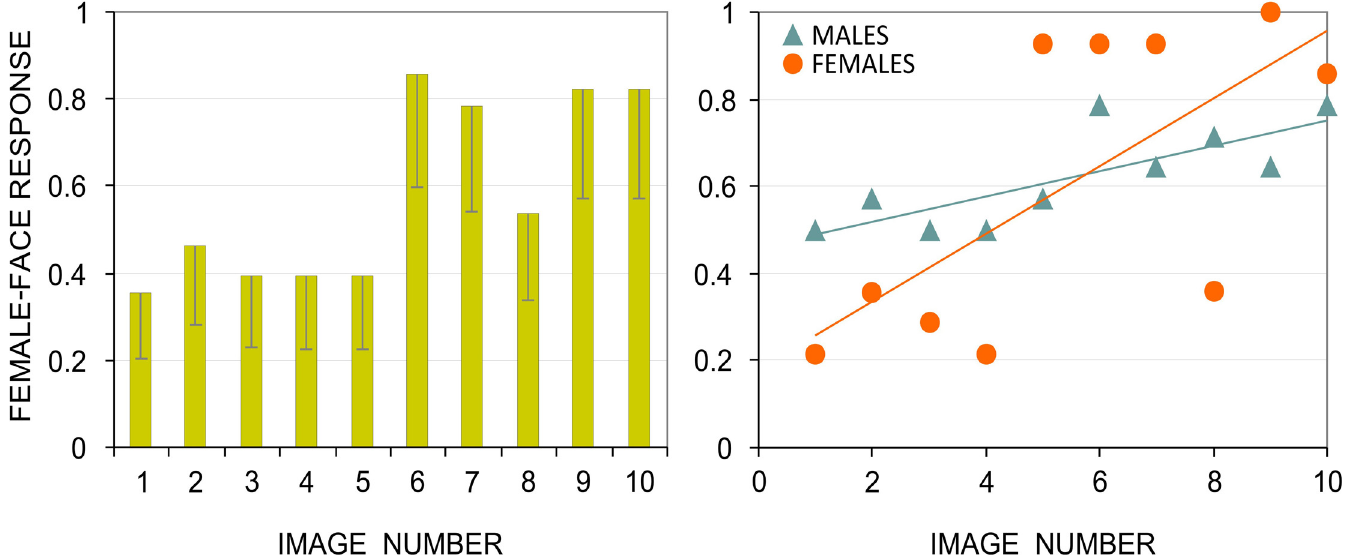
Fig 3. Proportion of female-face responses. Left: Proportion of female-face responses to each Face-n-Food image pooled across female and male perceivers. Vertical bars represent 95% CI (confidence interval). Right: Relationship between face resemblance and female-face impression shown separately for female and male perceivers. The image number reflects its face resemblance (1 – the least recognizable as a face, 10 – the most recognizable); trendlines are shown for illustrative purposes